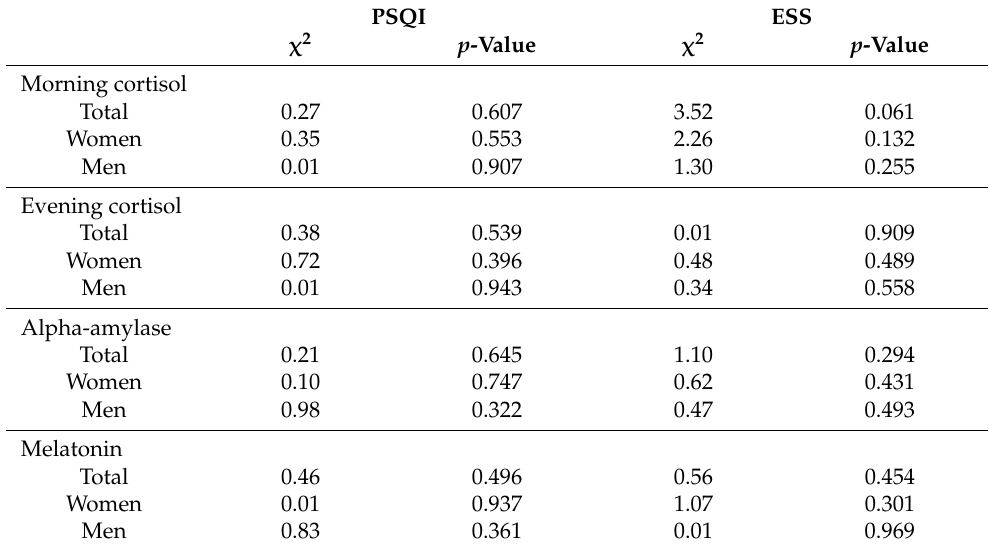
Table 6. Contingency analyses between perceived sleep quality scales and salivary biomarkers.